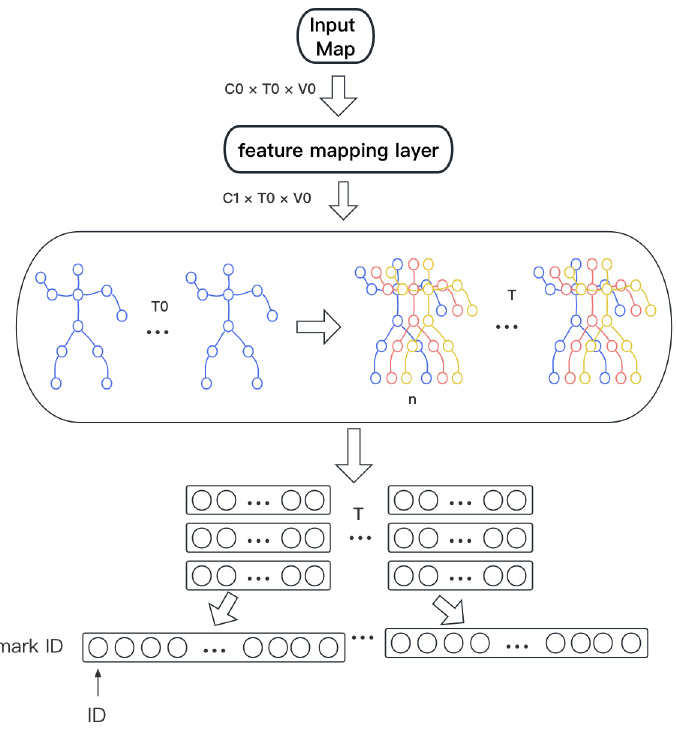
Figure 2. The process of segment